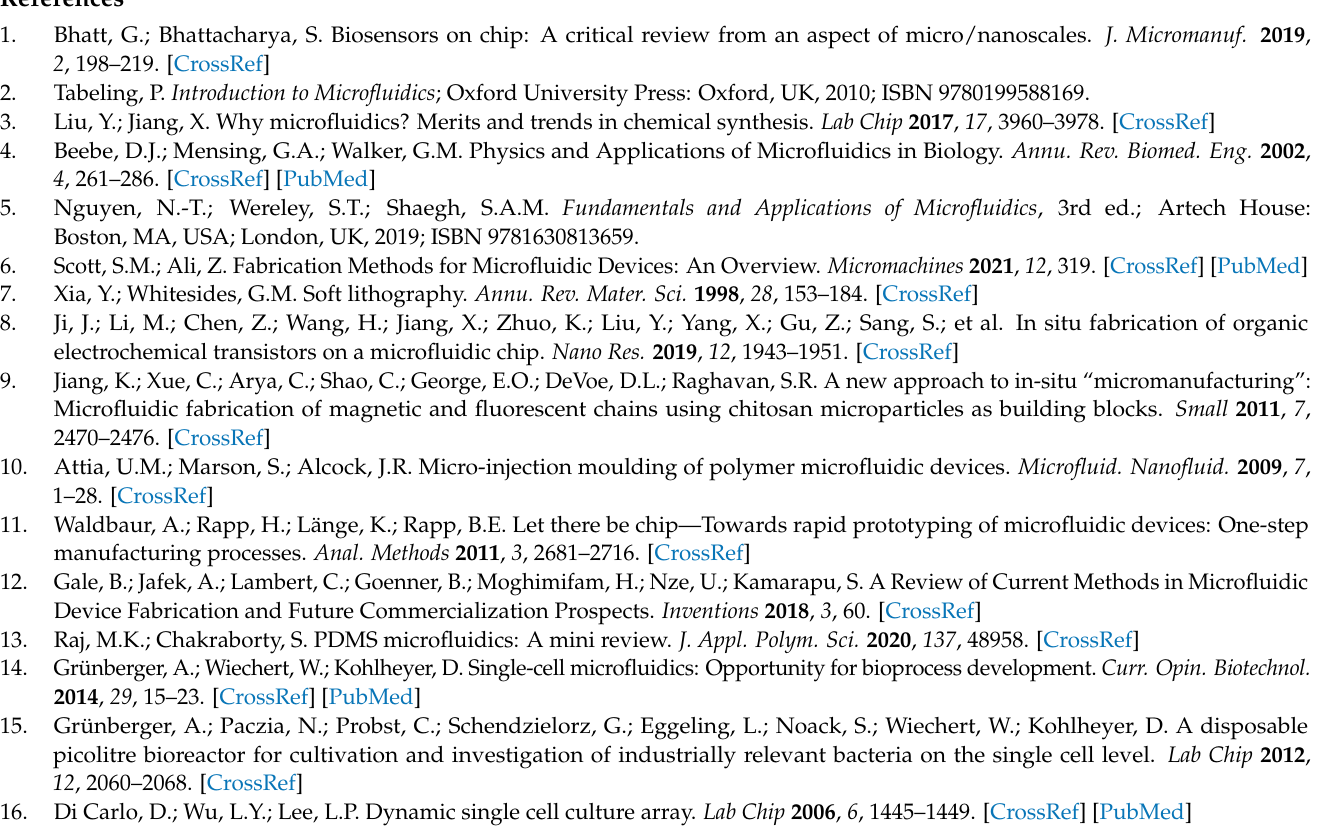
Figure A8. Example images of focus problems (see Table 11). Microscope images of ( A ) no steady focussing possible based on a bubble in the immersion oil and ( B ) shift in focus during cultivation.